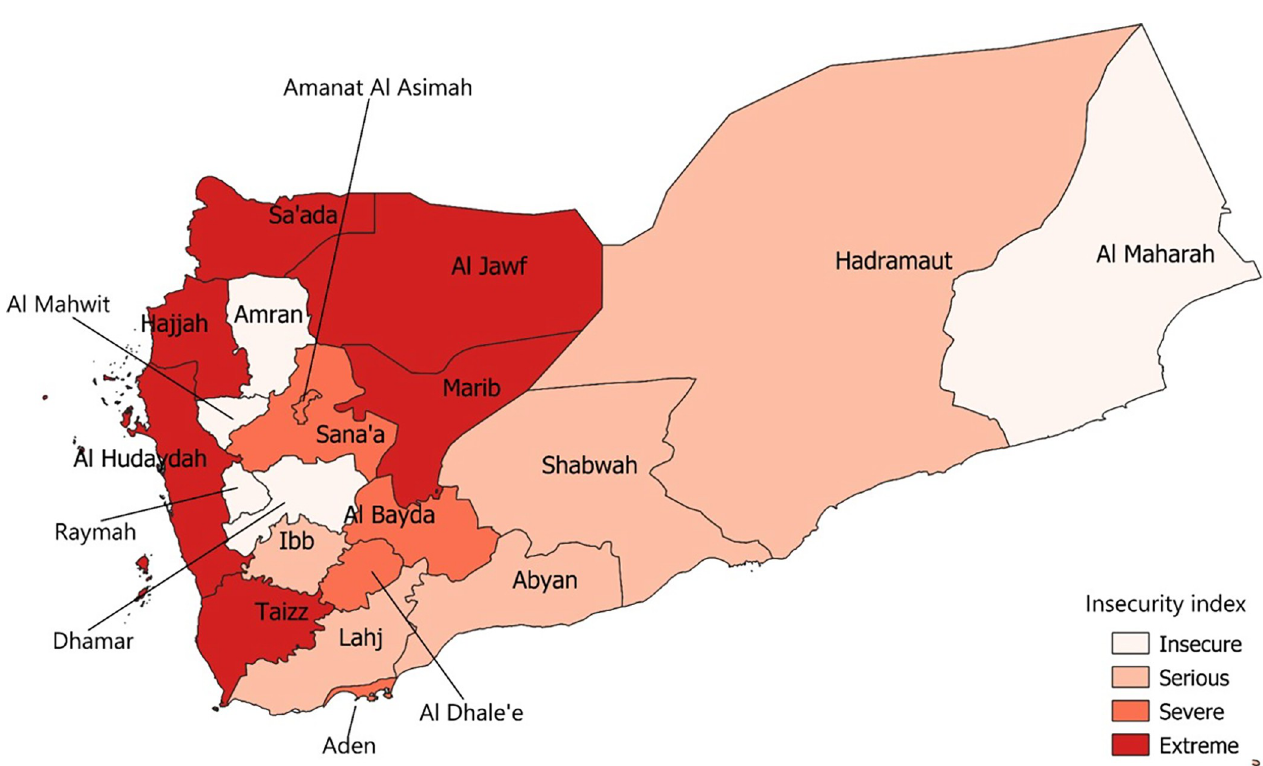
Fig 4. Posterior crude death rate by governorate and insecurity level, Yemen, 2015–2019. https://doi.org/10.1371/journal.pgph.0000581.g004 PLOS Global PublicHealth | https://doi.org/10.1371/journal.pgph.0000581 August 8,